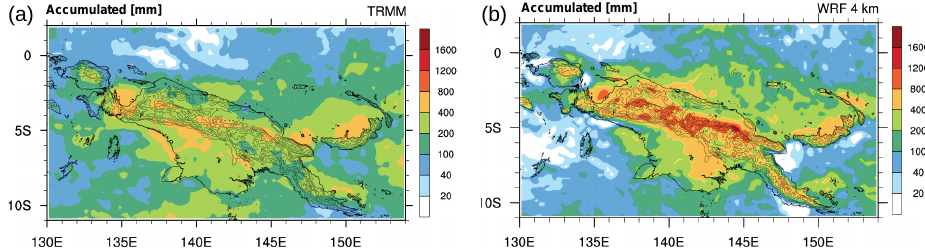
Figure 2. Accumulated rainfall (mm) for the New Guinea region between 2 and 28 February 2010 from TRMM (a) and the 4km WRF simulation (b) . Data from WRF have been coarse-grained to match the data resolution of the TRMM 3B42 gridded